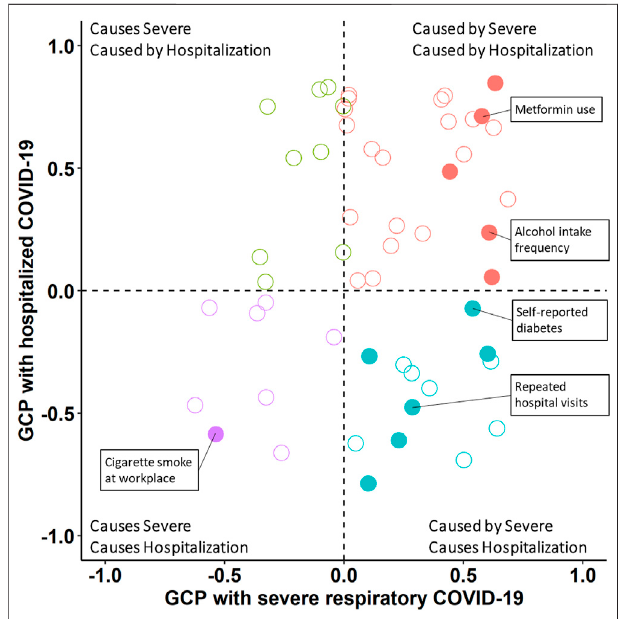
FIGURE 2 | Latent causal relationships between COVID-19 outcomes and signi fi cantly genetically correlated traits. Solid circles indicate a trait with signi fi cantgeneticcausalityproportion(gcp)withrespecttosevererespiratory COVID-19 and hospitalized COVID-19 and empty circles indicate non- signi fi cant gcp estimates. The color of each data point corresponds to the pattern of causal effect detected (labeled in the corner of each quadrant). Select traits arelabeled ineach quadrant andall gcpestimates areprovided in Supplementary Table S4